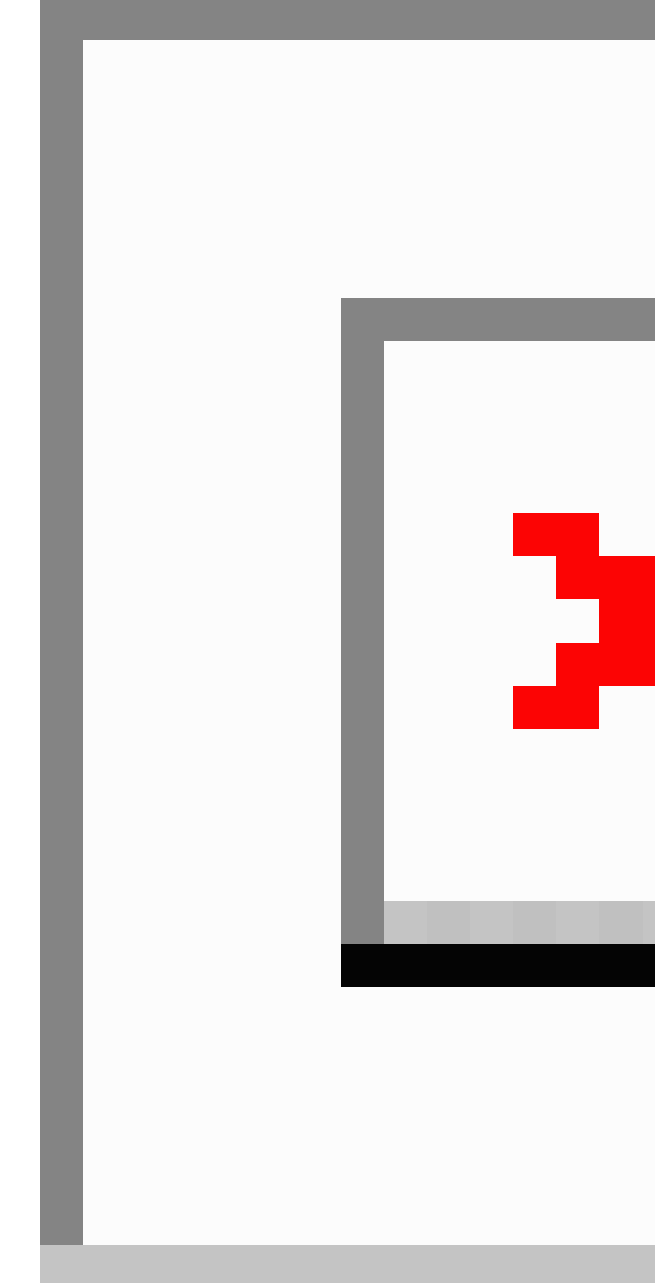
Figure 1. Overview of the data collection and analysis